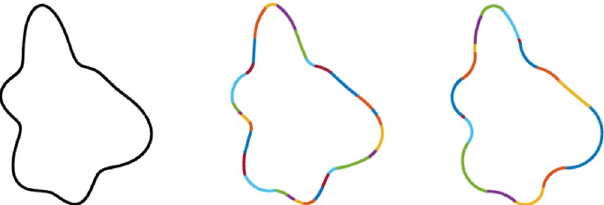
Fig 5. Two constant curvature representations of a shape contour. The original shape (left) is approximated with a small W (middle) and a large W (right). The smaller integration window has more segments and is more precise, organizing regions of the original shape with less variance in curvature into a single constant curvature segment (mean standard deviation of curvature = 0.02 per segment), while the larger integration window has fewer segments, but represents the contour less precisely, organizing regions with more curvature variance into single constant curvature segments (mean standard deviation of curvature = .05 per segment).